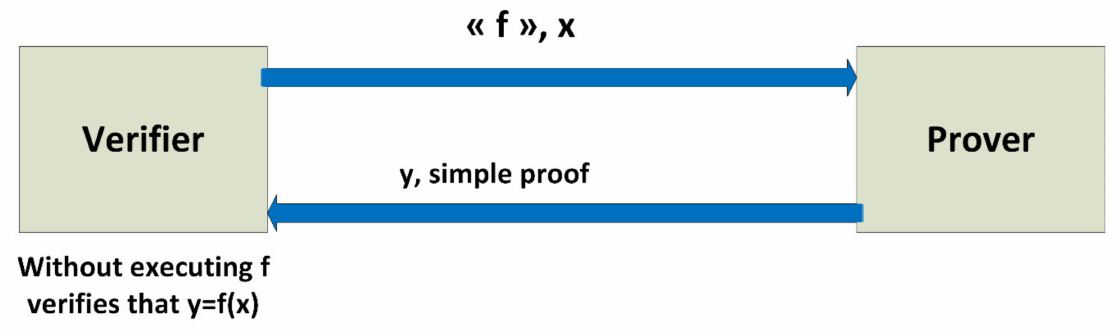
Figure 3. Conduct of verifiable computation between the prover and the